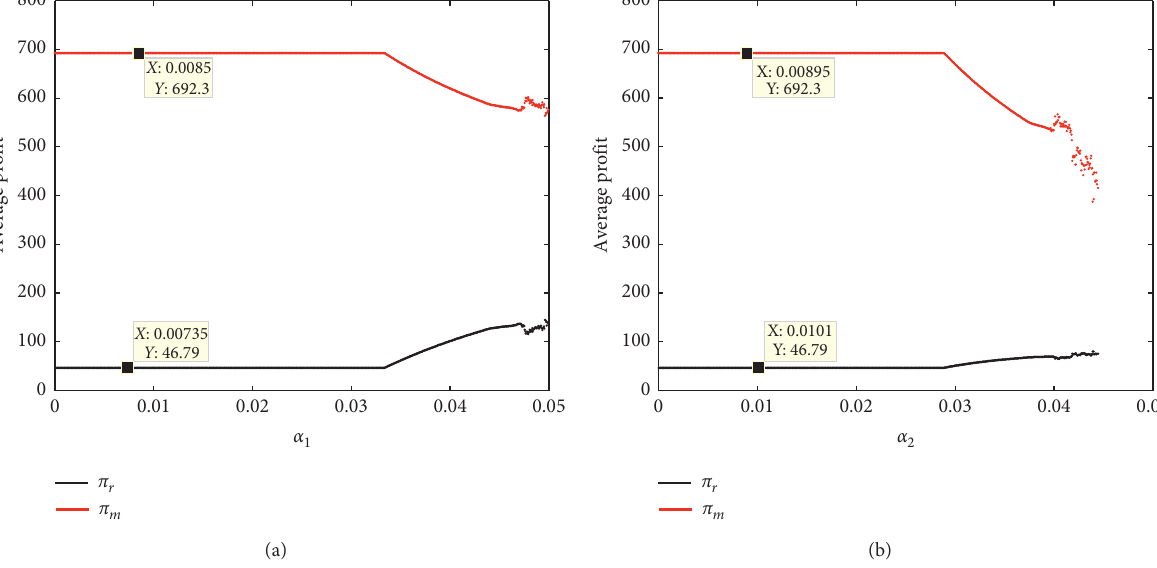
Figure 9: Change of average profit with respect to α